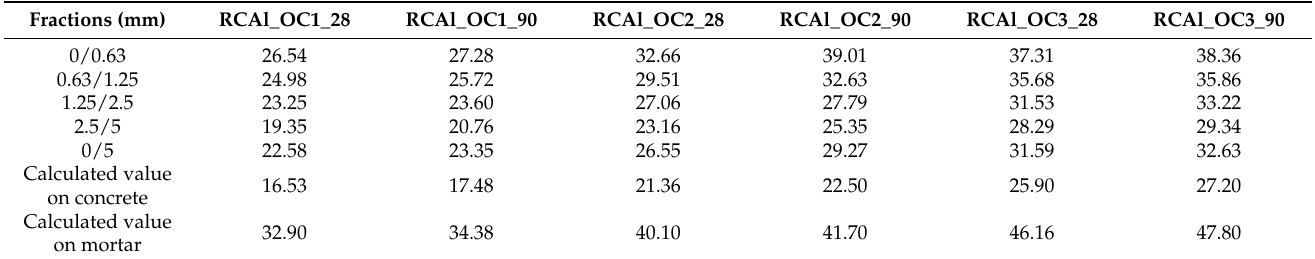
Table 7. SFSA for different granular classes of the laboratory-produced RCA (unit: %, the numbers 28 and 90 refer to the aging of the original concrete samples in